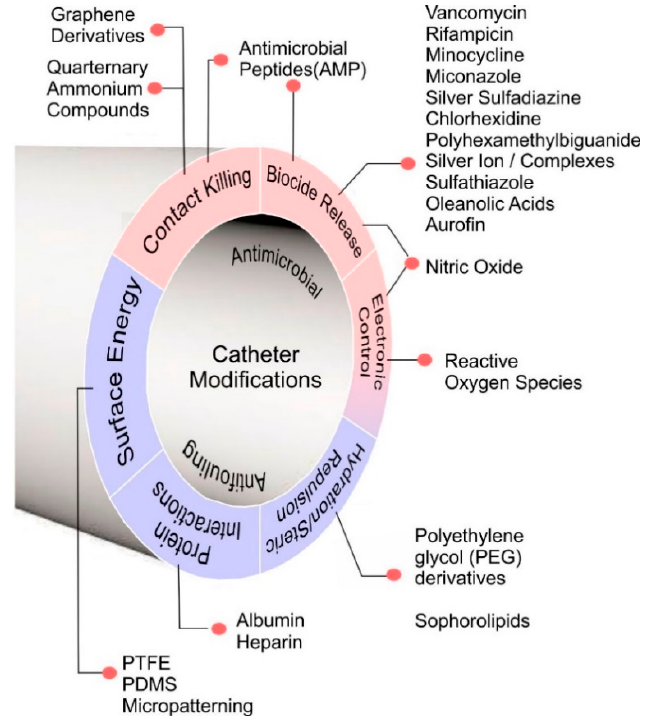
Figure 5. Material approaches to counter bacterial colonisation of central venous catheters.